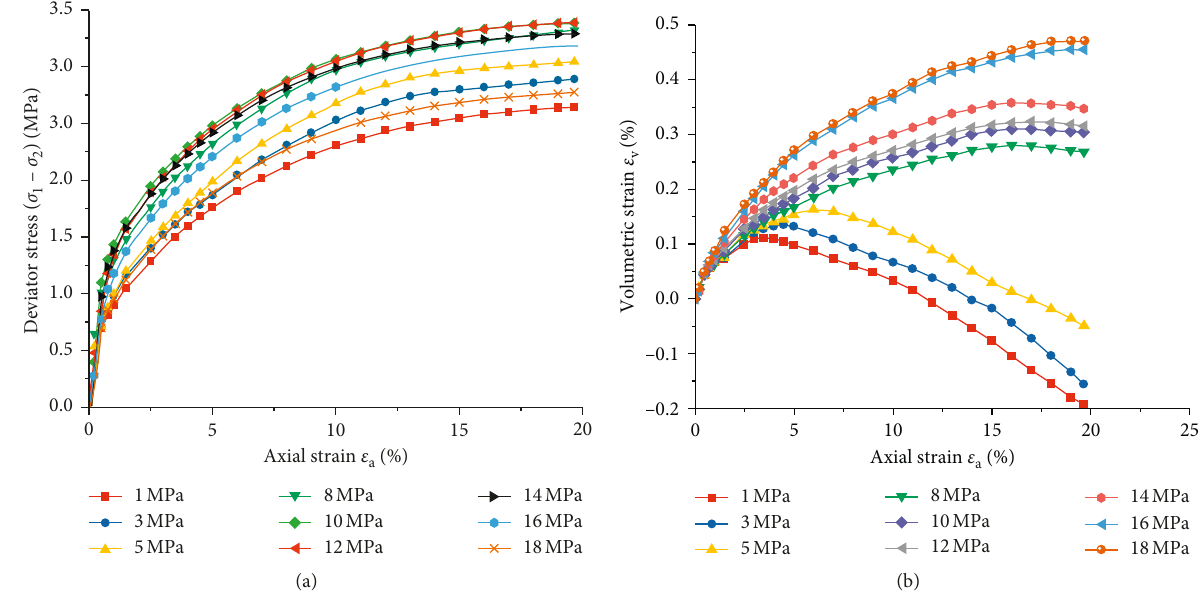
Figure 1: The typical stress-strain curves of frozen saline silty clay with salt content 1.5%.